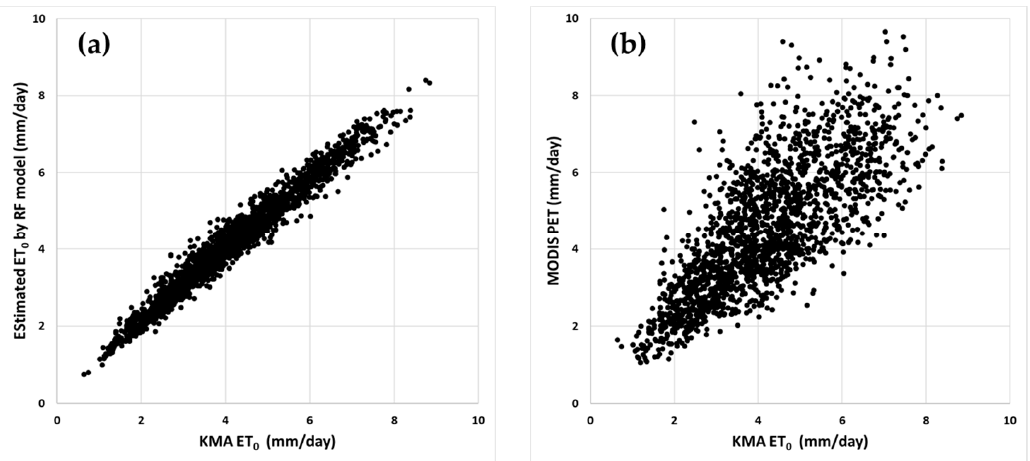
Figure 11. Scatterplots of the ML-based ET 0 vs. KMA in situ data ( a ) and the MODIS PET vs. KMA in